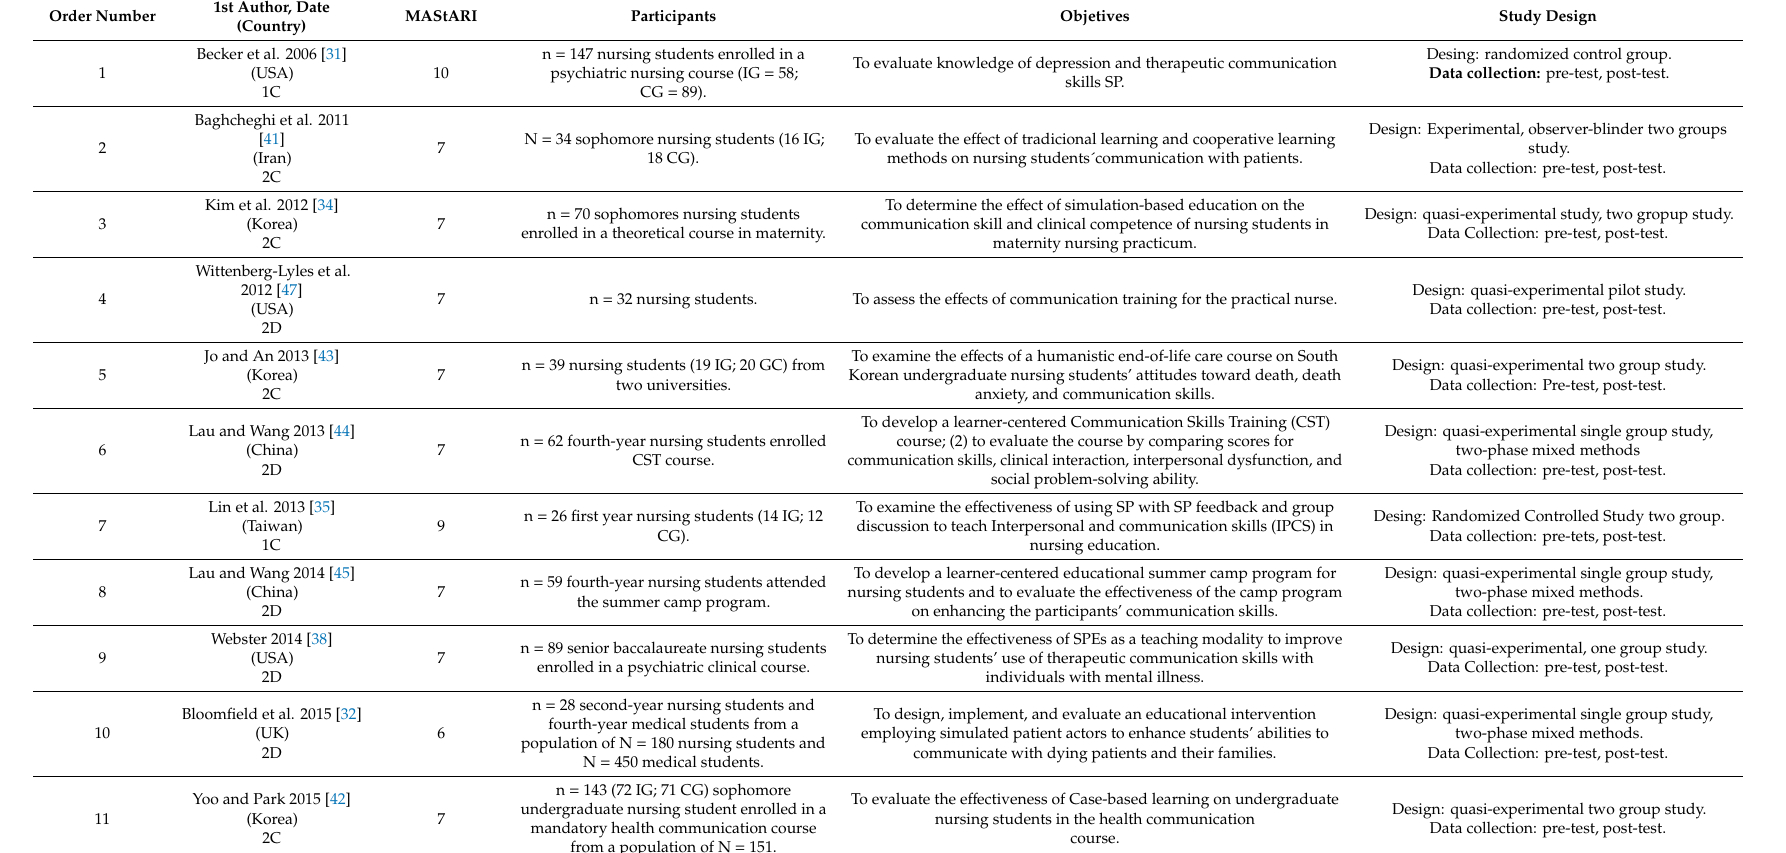
Table 1. Main characteristics of the selected